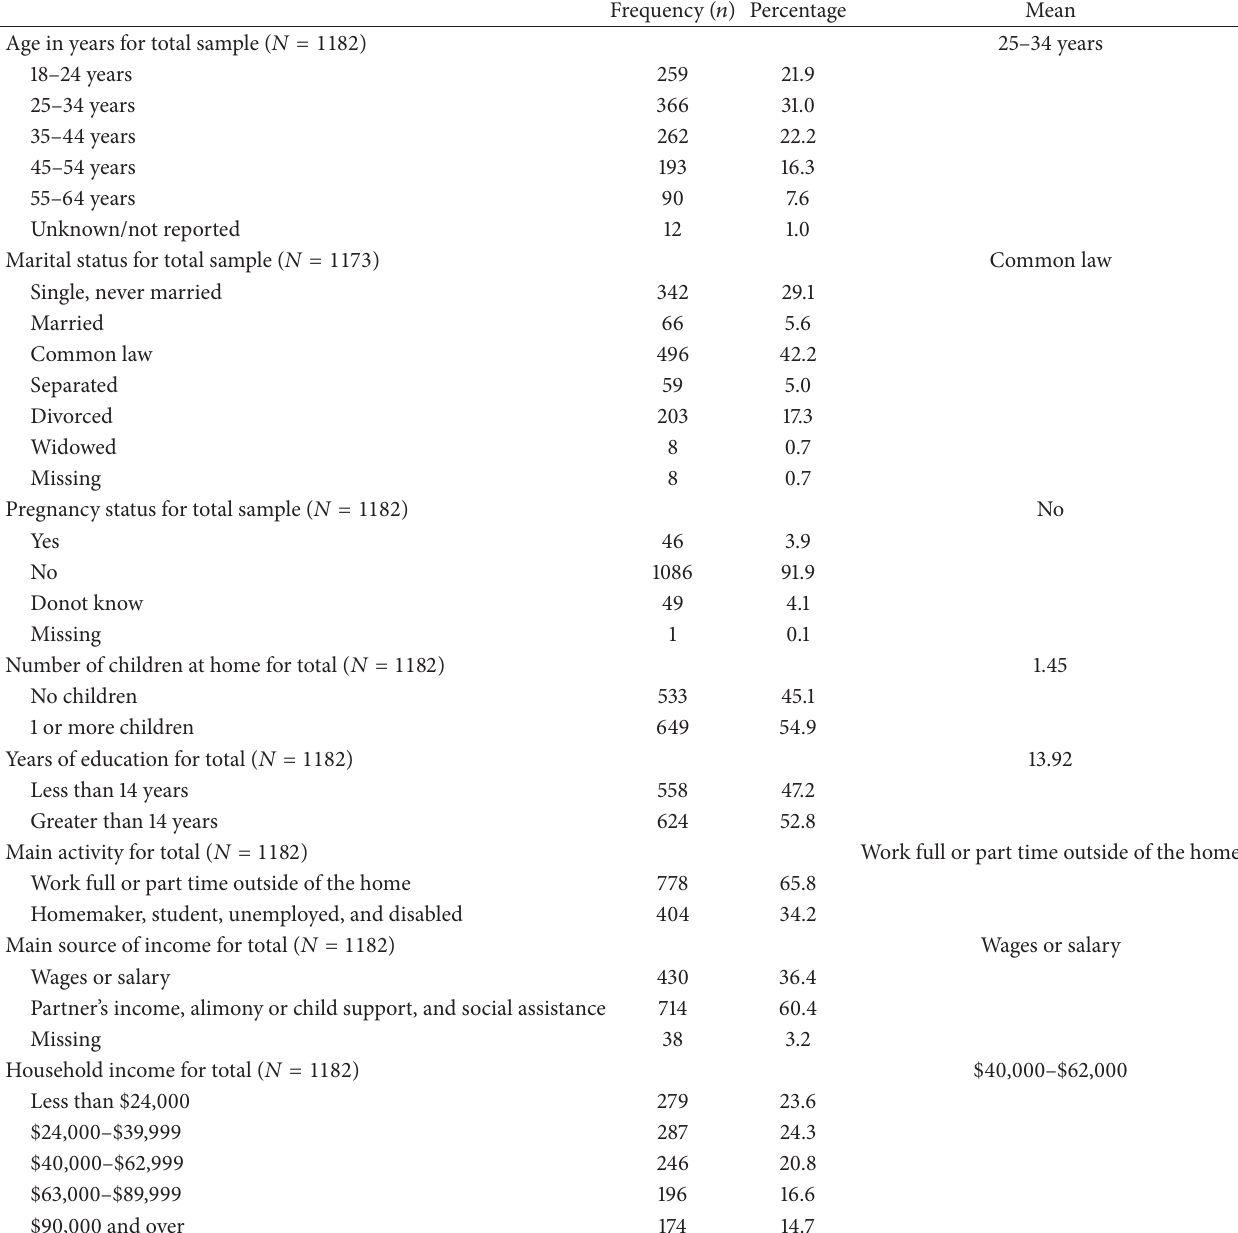
Table 1: Quantitative subanalysis results: demographic summary across screen and nonscreen groups.